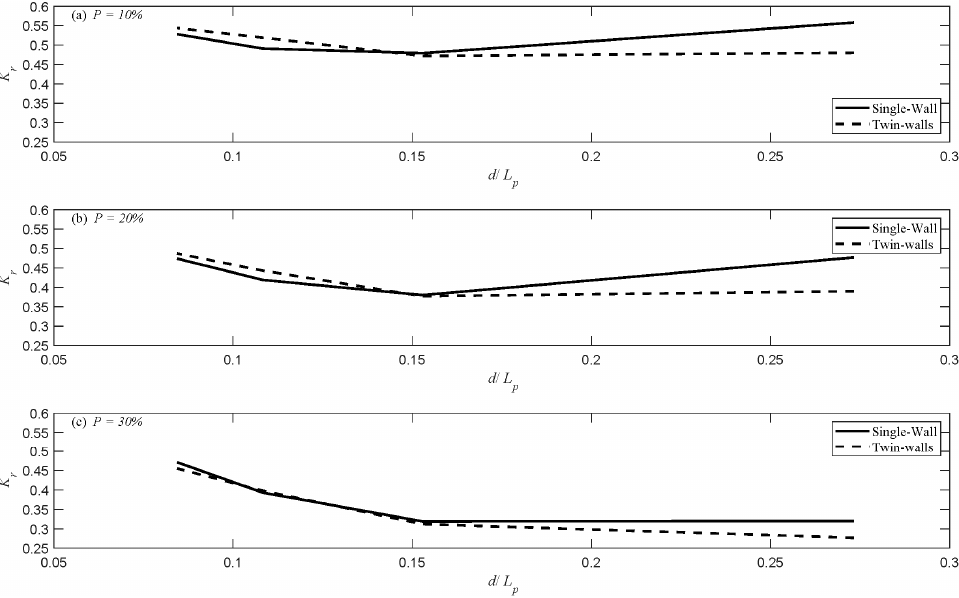
Figure 13. Effect of the number of walls on K r . θ = 60°, and H is / d = 0.1284. ( a ) P = 10%, ( b ) P = 20%, and ( c ) P = 30%.